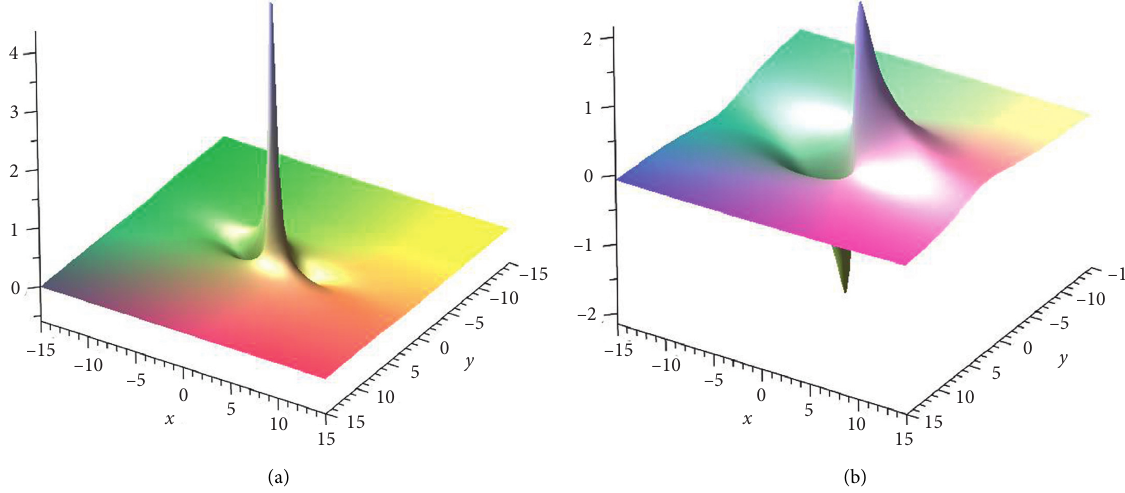
Figure 4: The breather solution v of equation (1) with the parameter selections m � 2 , p � 0 , k � 2 , δ